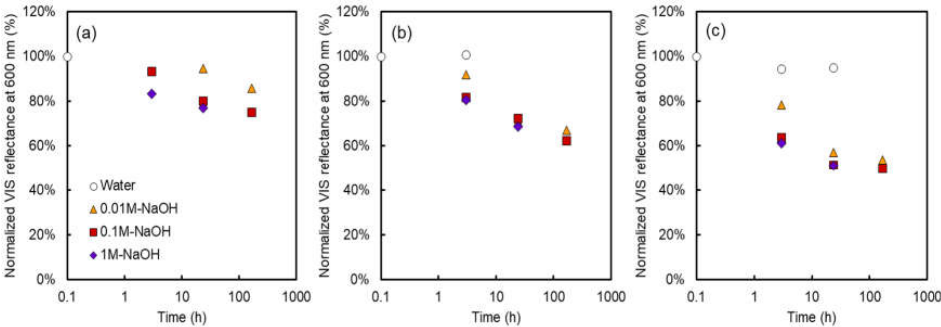
Figure 3. Normalized relative total visible (VIS) reflectance as a function of the time after immersion into NaOH solution. The temperature of the alkali immersion test: ( a ) 40 °C, ( b ) 60 °C, ( c ) 80 °C.